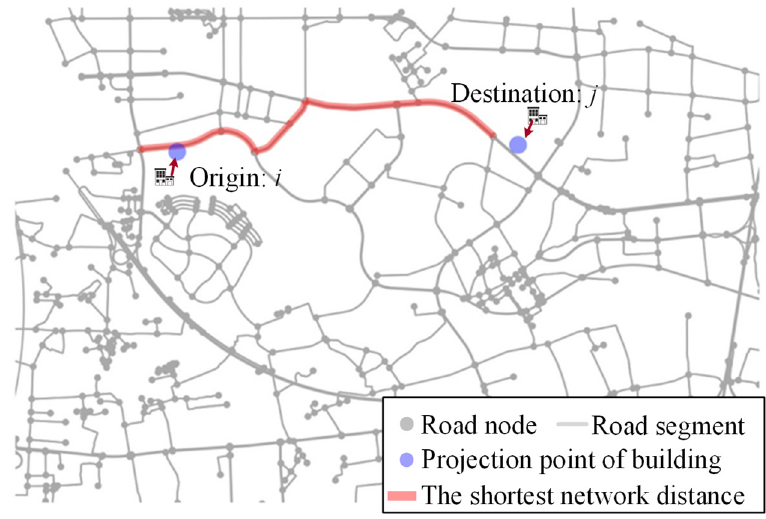
Figure 3. Network distance from an origin i to a destination j .